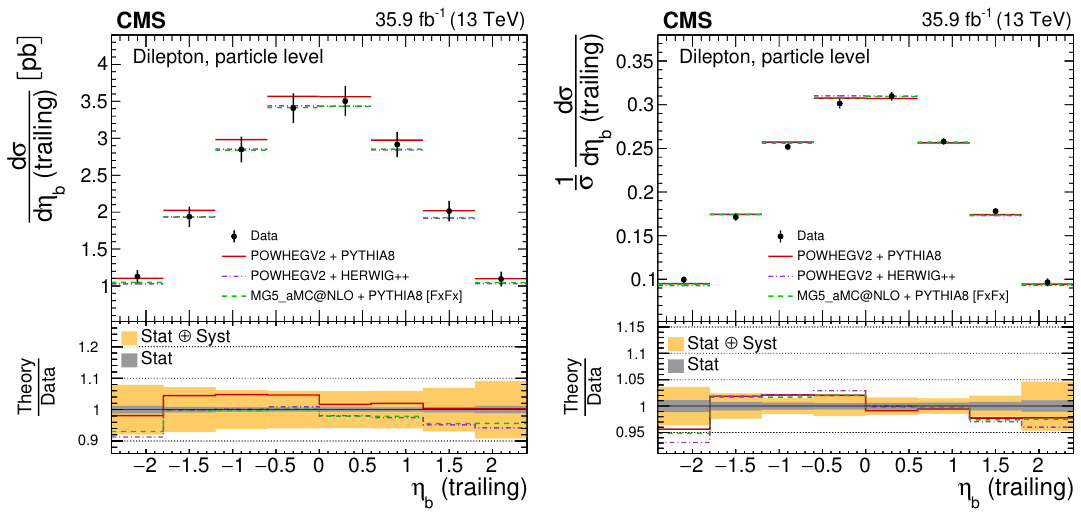
Figure 48 . The di(cid:11)erential tt production cross sections as a function of (cid:17) b (trailing) in a (cid:12)ducial phase space at the particle level are shown for the data (points) and the MC predictions (lines). The vertical lines on the points indicate the total uncertainty in the data. The left and right plots correspond to absolute and normalised measurements, respectively. The lower panel in each plot shows the ratios of the theoretical predictions to the data. The dark and light bands show the relative statistical and total uncertainties in the data,